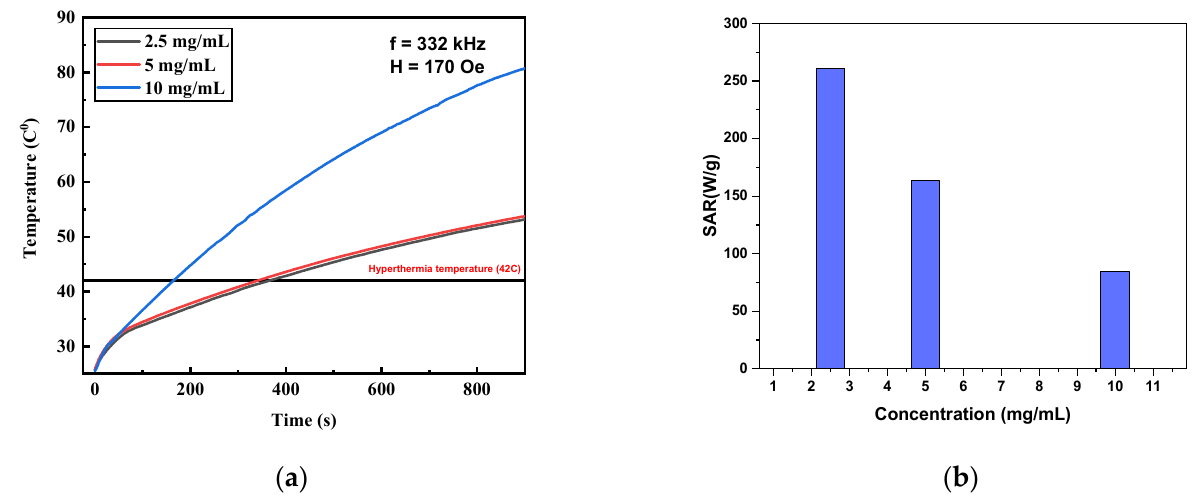
Figure 5. ( a ) Temperature rise for different concentrations and ( b ) SAR values as function of concentration. Table 1. Heating characteristics for different concentrations of Fe 3 O 4 MNPs at a field amplitude H 0 = 170 Oe and a frequency f = 332.8